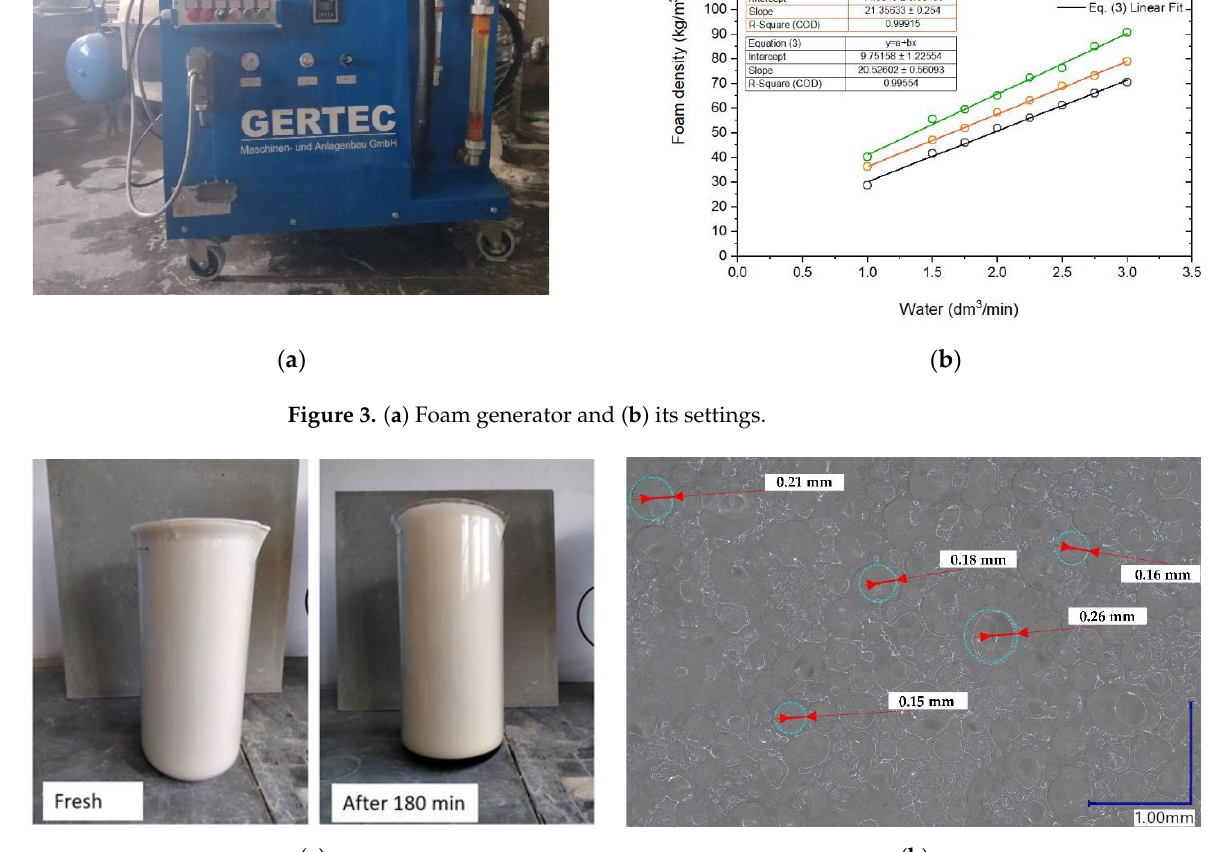
Figure 3. ( a ) Foam generator and ( b ) its settings.